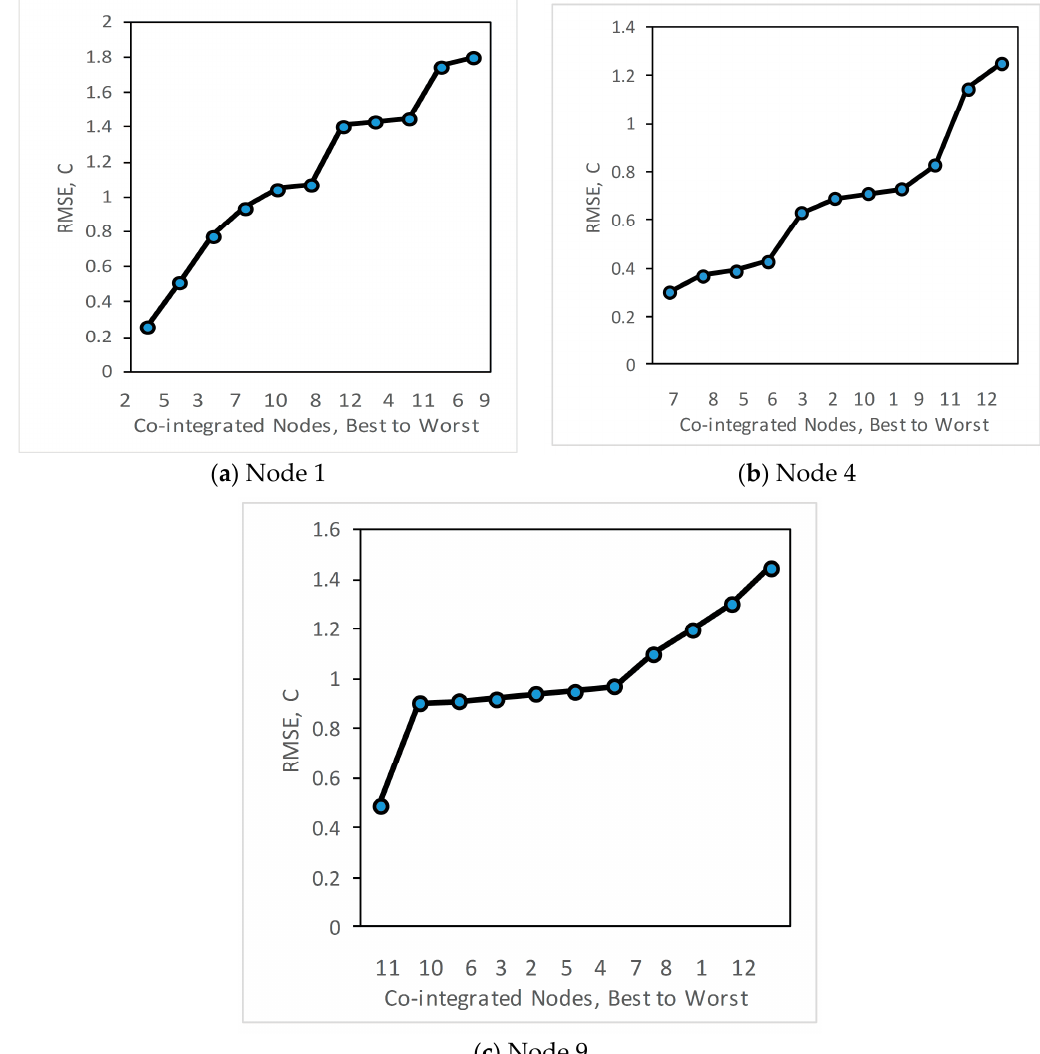
Figure 4. Root Mean-squared estimation error for co-integrated series at ( a ) Node 1, and ( b ) Node 4, and ( c ) Node 9, using all other nodes as estimators.